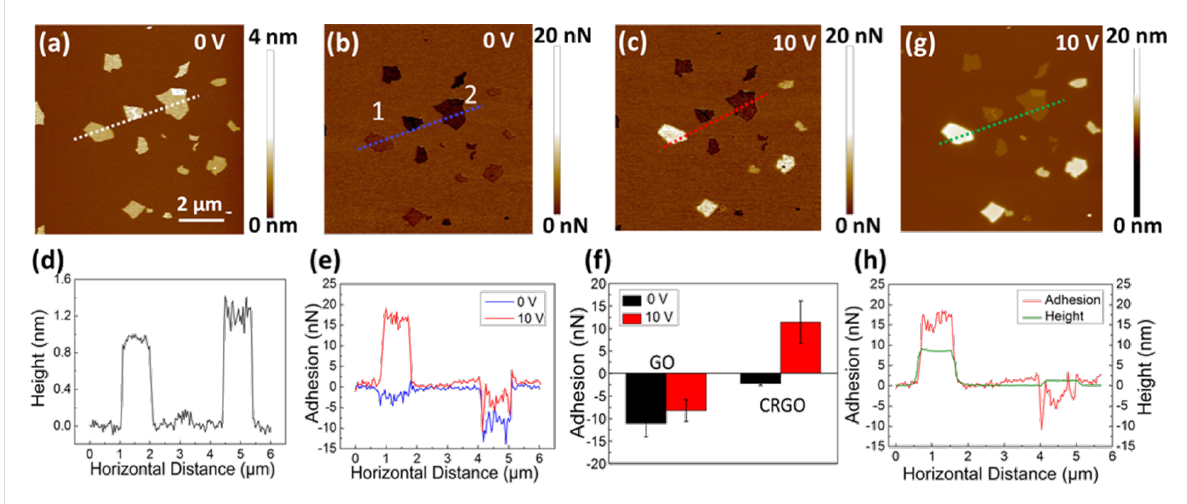
Figure 3: Discrimination of GO and CRGO on mica by adhesion mapping with a biased AFM tip. (a) Height and (b) adhesion force images taken si- multaneously under an AFM tip bias of 0 V in PQ-QNM mode. (c) Adhesion force image taken under an AFM tip bias of 10 V. All of the images were taken with the peakforce set point at 5 nN under ambient conditions. (d) Cross-sectional profiles of the white dotted line in (a). (e) Cross sectional profiles of the blue and red dotted lines in (b) and (c), respectively. (f) The average adhesion forces of GO and RGO sheets under AFM tip biases of 0 and 10 V, respectively. (g) An in situ SPFM image of (c) taken under an AFM tip bias of 10 V with RH 10%. (h) Cross-sectional profiles of the red and green dotted lines in (c) and